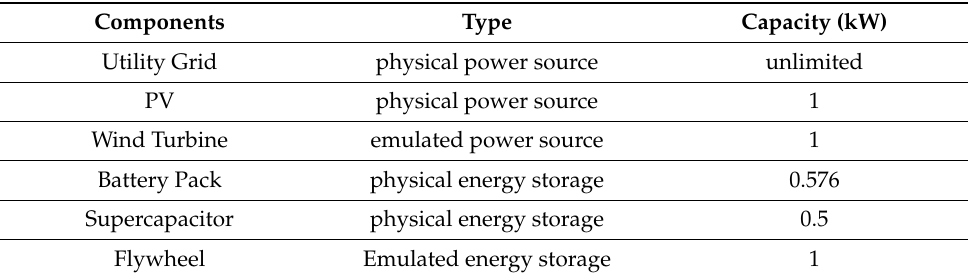
Table 1. MEG system components and